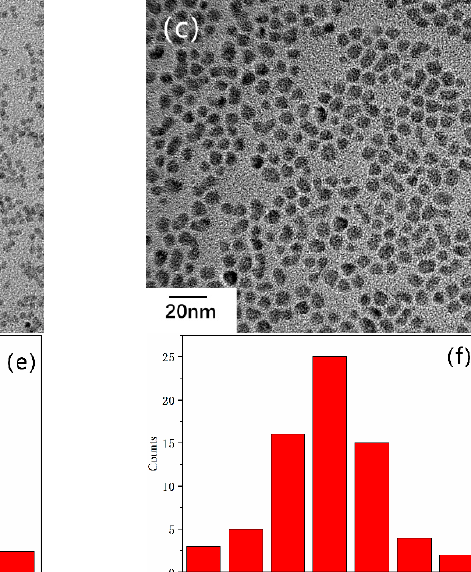
Figure 2. TEM images of ( a ) CdS ( b ) CdSe ( c ) CdTe NCs. (Scale bar 20 nm), particle size distribution of ( d )CdS ( e ) CdSe ( f ) CdTe NCs.